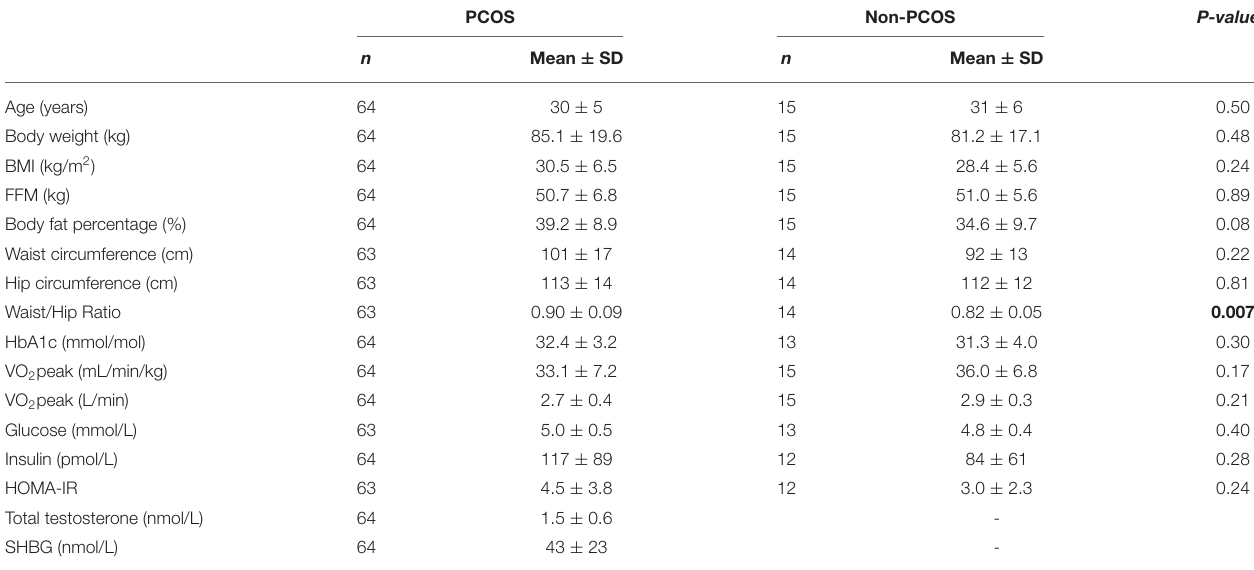
TABLE 1 | Baseline characteristics of PCOS and non-PCOS